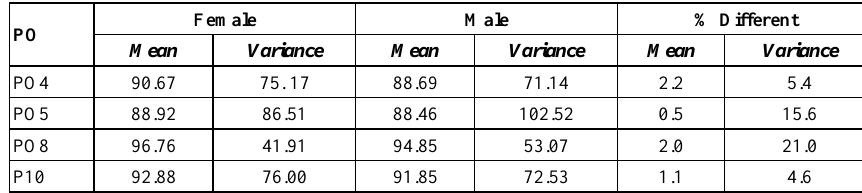
Table 7. Mean and Variance based on gender